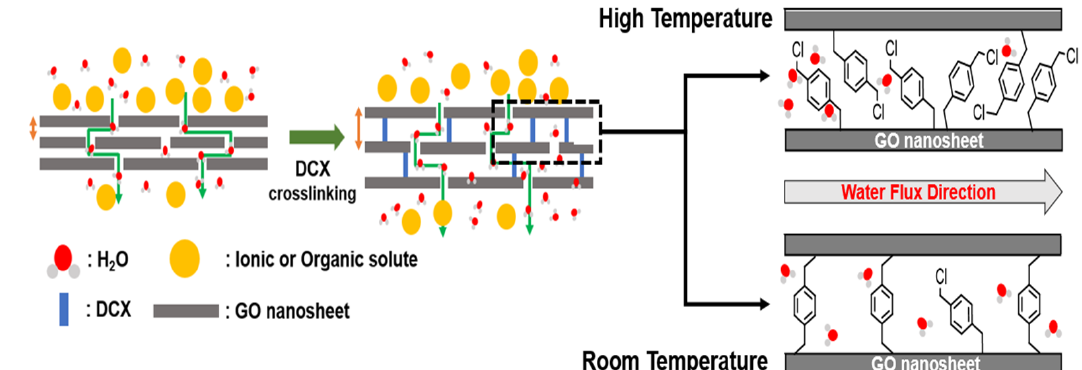
Figure 5. Schematic of the molecular transport in the GO laminate membranes with and without DCX crosslinking. The hypothetical nanochannel structures of the GO membranes crosslinked with DCX under room-temperature and high-temperature conditions are also shown on the right.